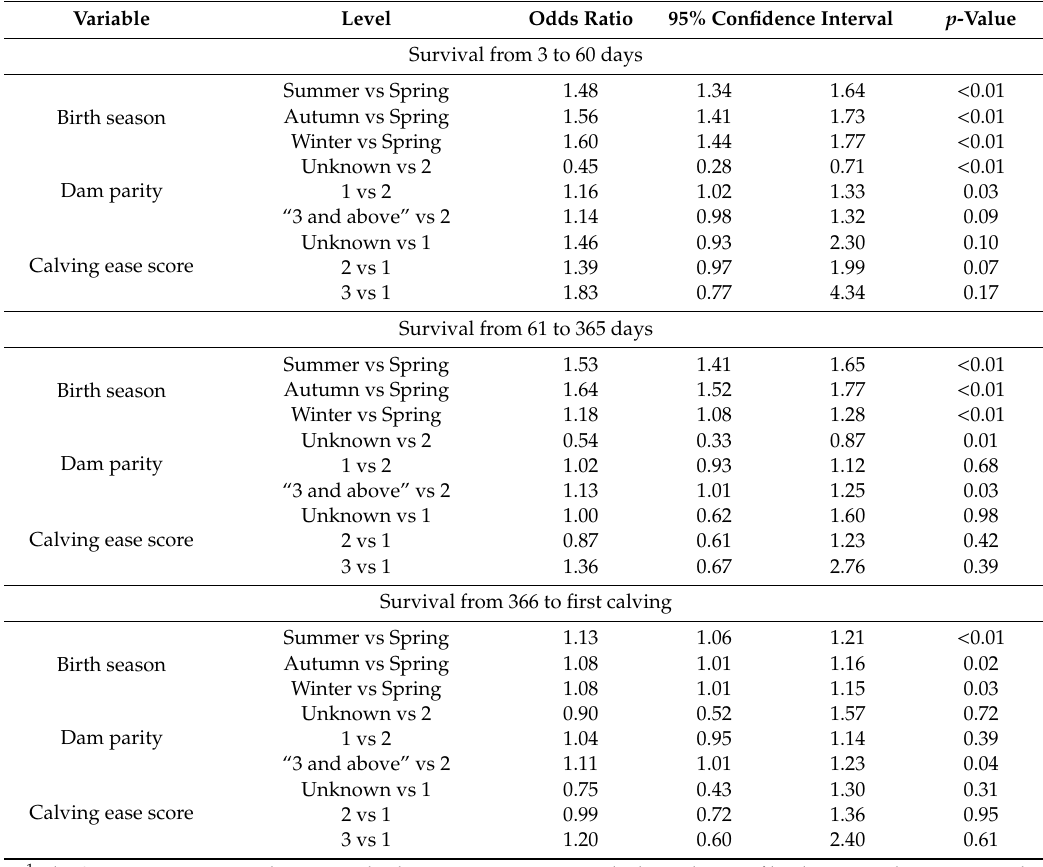
Table 2. Associations between di ff erent levels of birth season, dam parity and calving ease score on the odds ratio of mortality 1